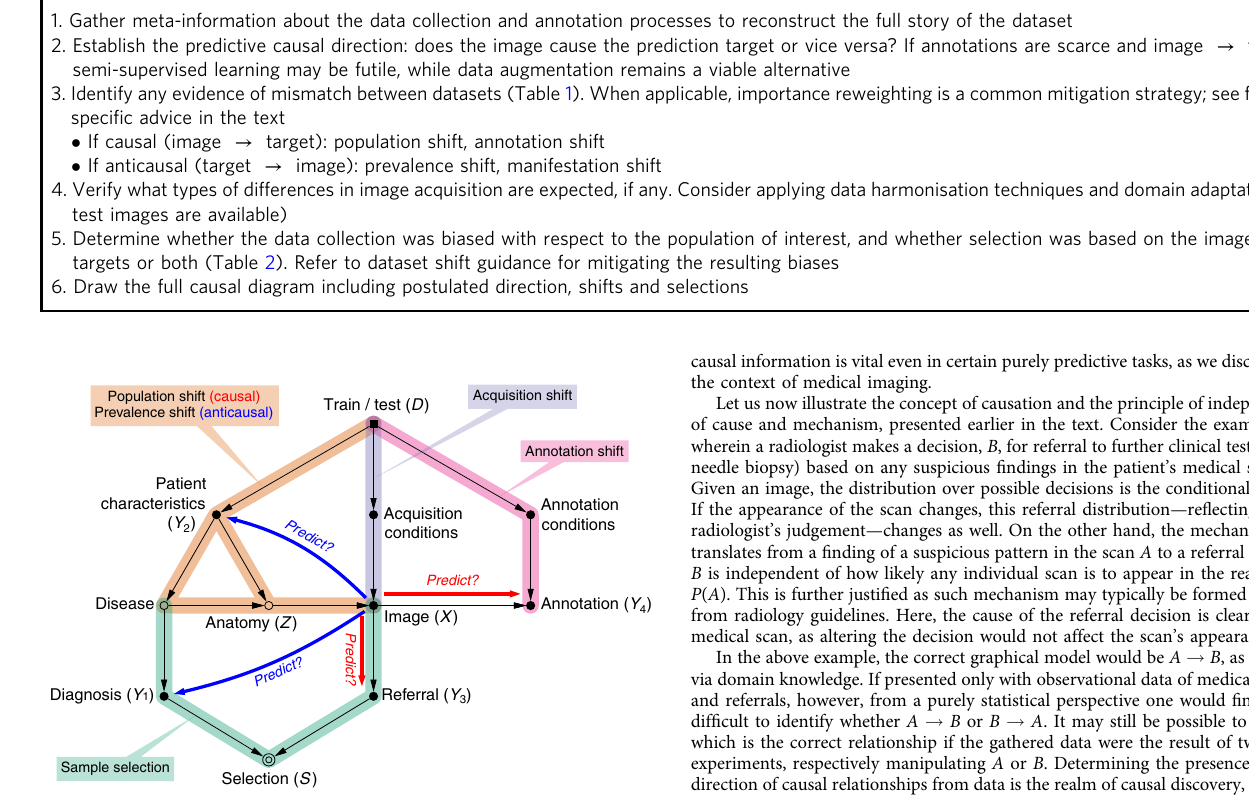
Table 3 Step-by-step recommendations. 1. Gather meta-information about the data collection and annotation processes to reconstruct the full story of the dataset 2. Establish the predictive causal direction: does the image cause the prediction target or vice versa? If annotations are scarce and image → target, semi-supervised learning may be futile, while data augmentation remains a viable alternative 3. Identify any evidence of mismatch between datasets (Table 1). When applicable, importance reweighting is a common mitigation strategy; see further